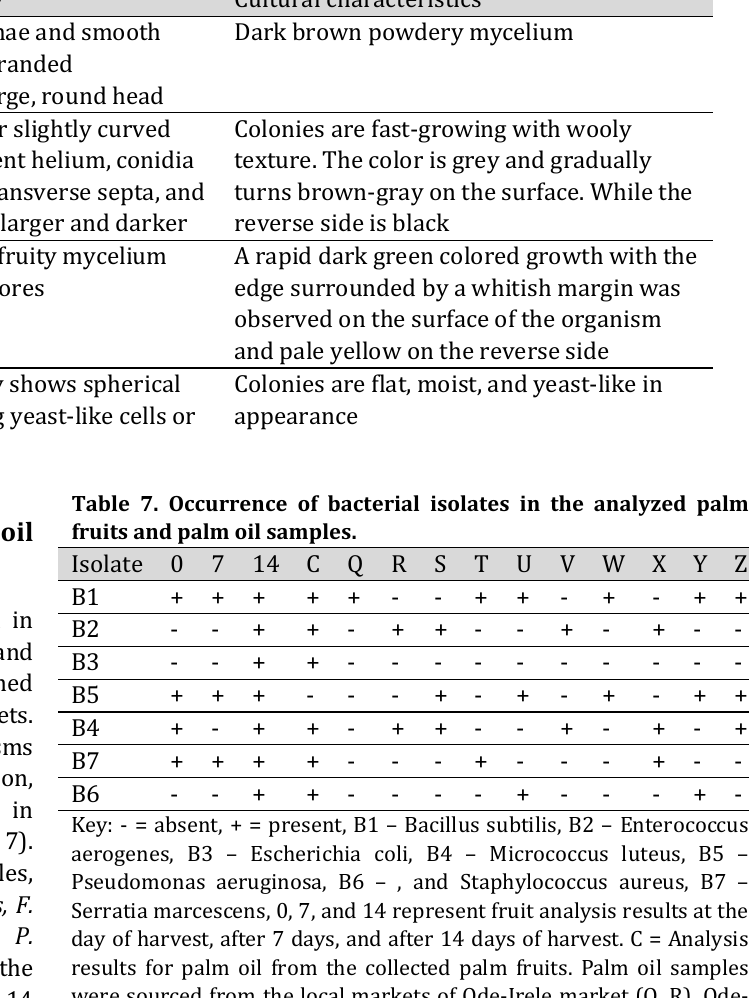
Fungal isolates